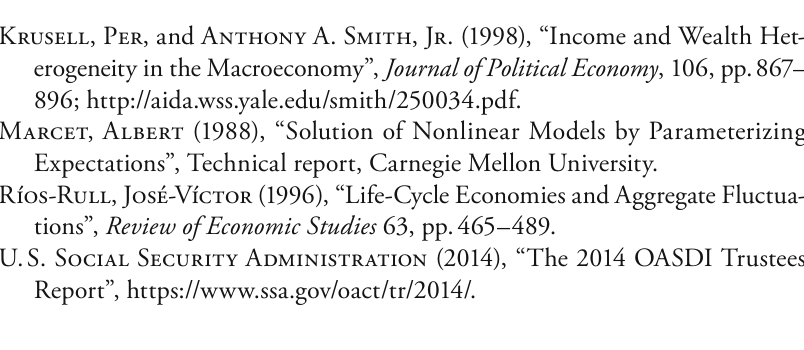
Table II.B1: Summary of 2013 Trust Fund Financial Operations (in Billion $) OASI DI OASDI Asset reserves at the end of 2012 2,609.7 122.7 2,732.3 Total income in 2013 743.8 111.2